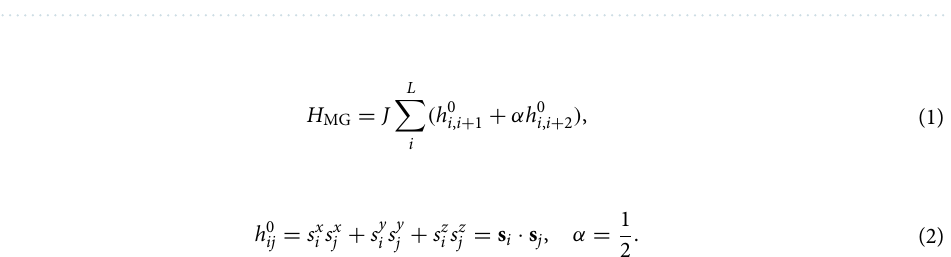
Figure 1. ( a ) The model in Eq. (9) with nearest J and next-nearest-neighbor interaction J α . ( b ) The schematic illustration of the two exact dimer states, in which each singlet dimer is represented by a solid bound (see the exact definition of the wave function in Eq.